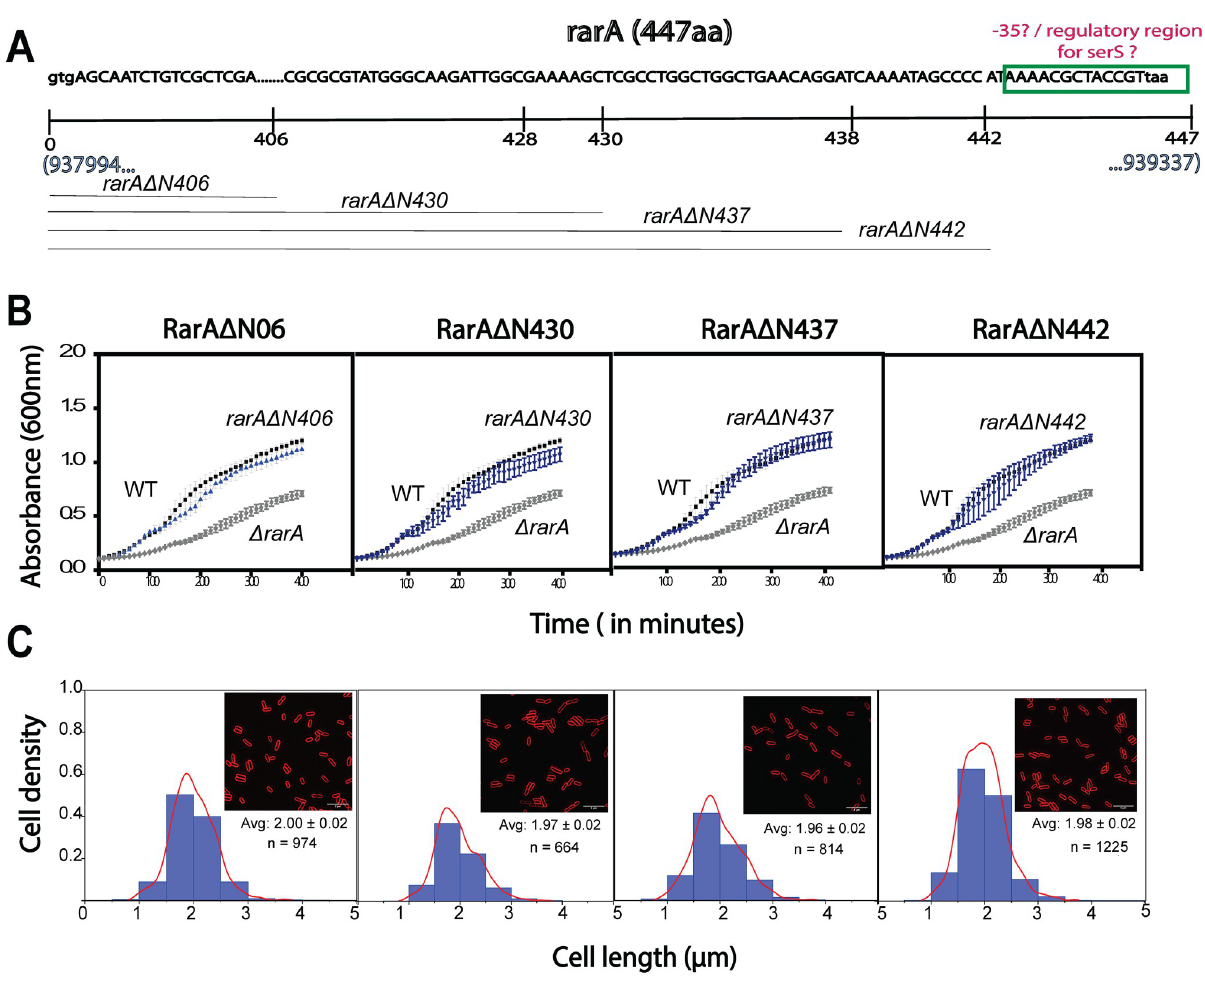
Fig 4. Analysis of the effect of various rarA deletion ( rarA Δ N406, rarA Δ N430, rarA Δ N437, and rarA Δ N442) on the growth and cell size. (A) Schematic of rarA gene, highlighting the possible promoter regions and positions of different deletions made. (B) Growth curve: Δ rarAN406 , Δ rarAN430 , Δ rarAN437 , Δ rarAN442 does not exhibit a growth defect (C) Cell size: rarA Δ N406 , rarA Δ N430 , rarA Δ N437 , rarA Δ N442 has cell morphology comparable to WT.